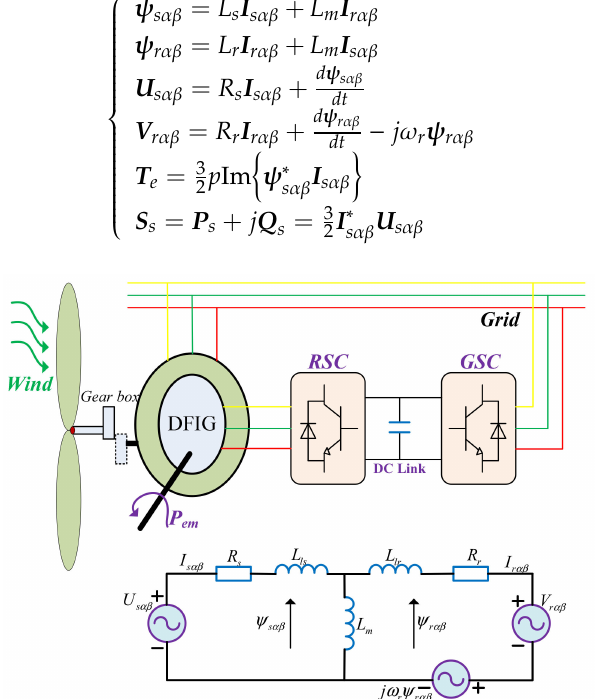
Figure 1. Doubly-fed induction generator (DFIG)-based wind power system schematic diagram and DFIG equivalent circuit under a two-phase stationary coordinate